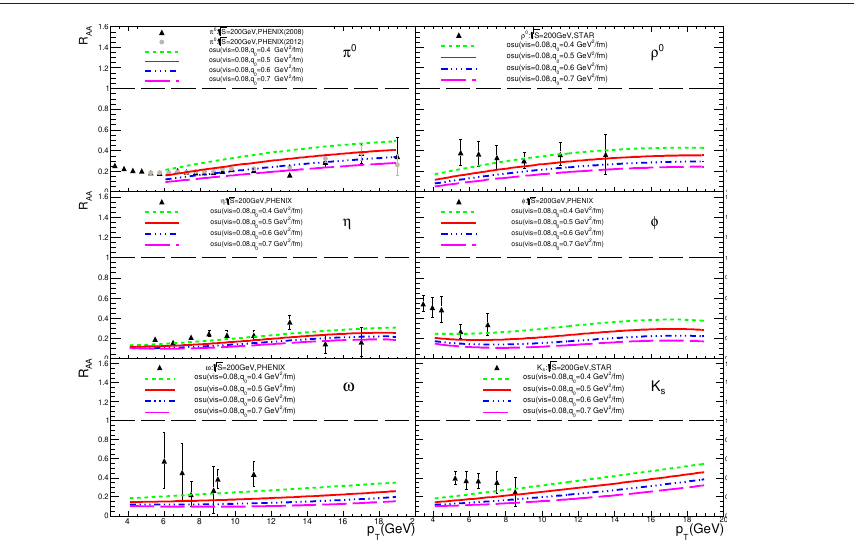
Figure 5. Comparison of theoretical simulations of R AA at ˆ q 0 = 0 . 4 mental measurements of π 0 [25, 31], ρ 0 [25], η [32], φ [33], ω [34], K 0